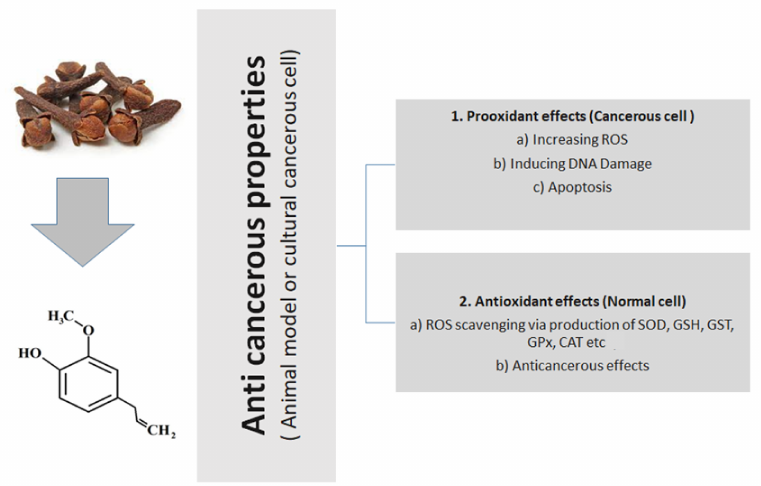
Figure 3. General anticancerous action of eugenol (tried and tested in animal or cultural cancerous cell